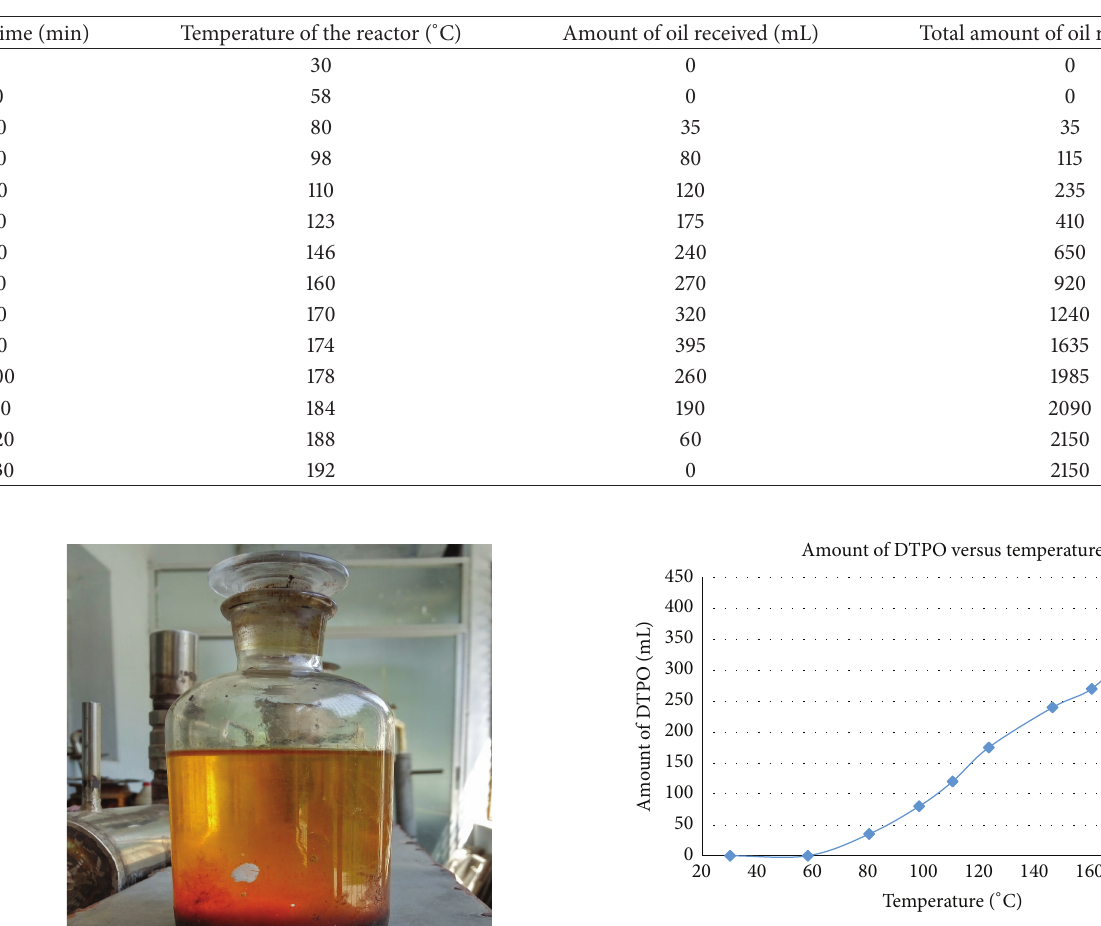
Table 3: Experimental data for distilled oil procurement at different temperature.